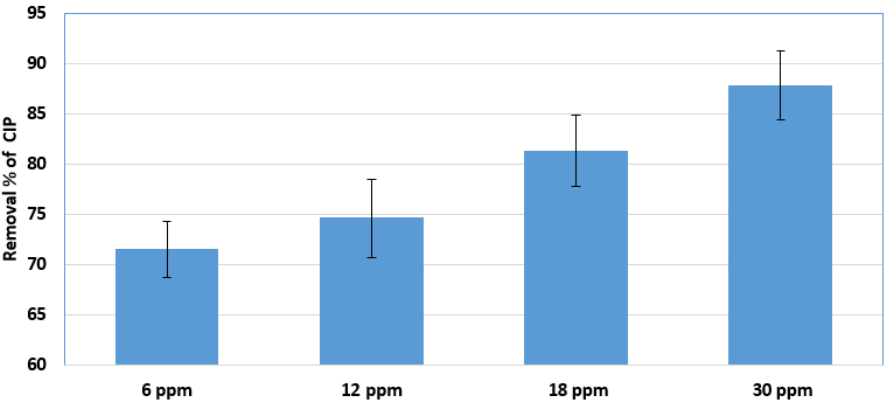
Figure 8. Variation in removal efficiency with the initial CIP concentration at pH = 5 and feed flow rate = 0.4 L/min.